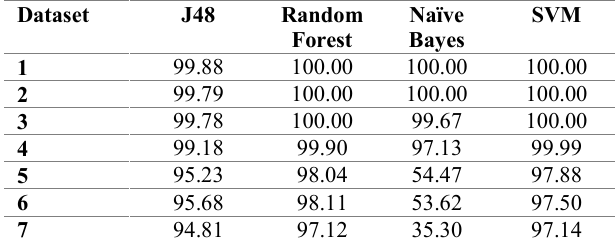
Table 2. Percentage correctly classified with a significance level of 0.001 (two-tailed confidence level of